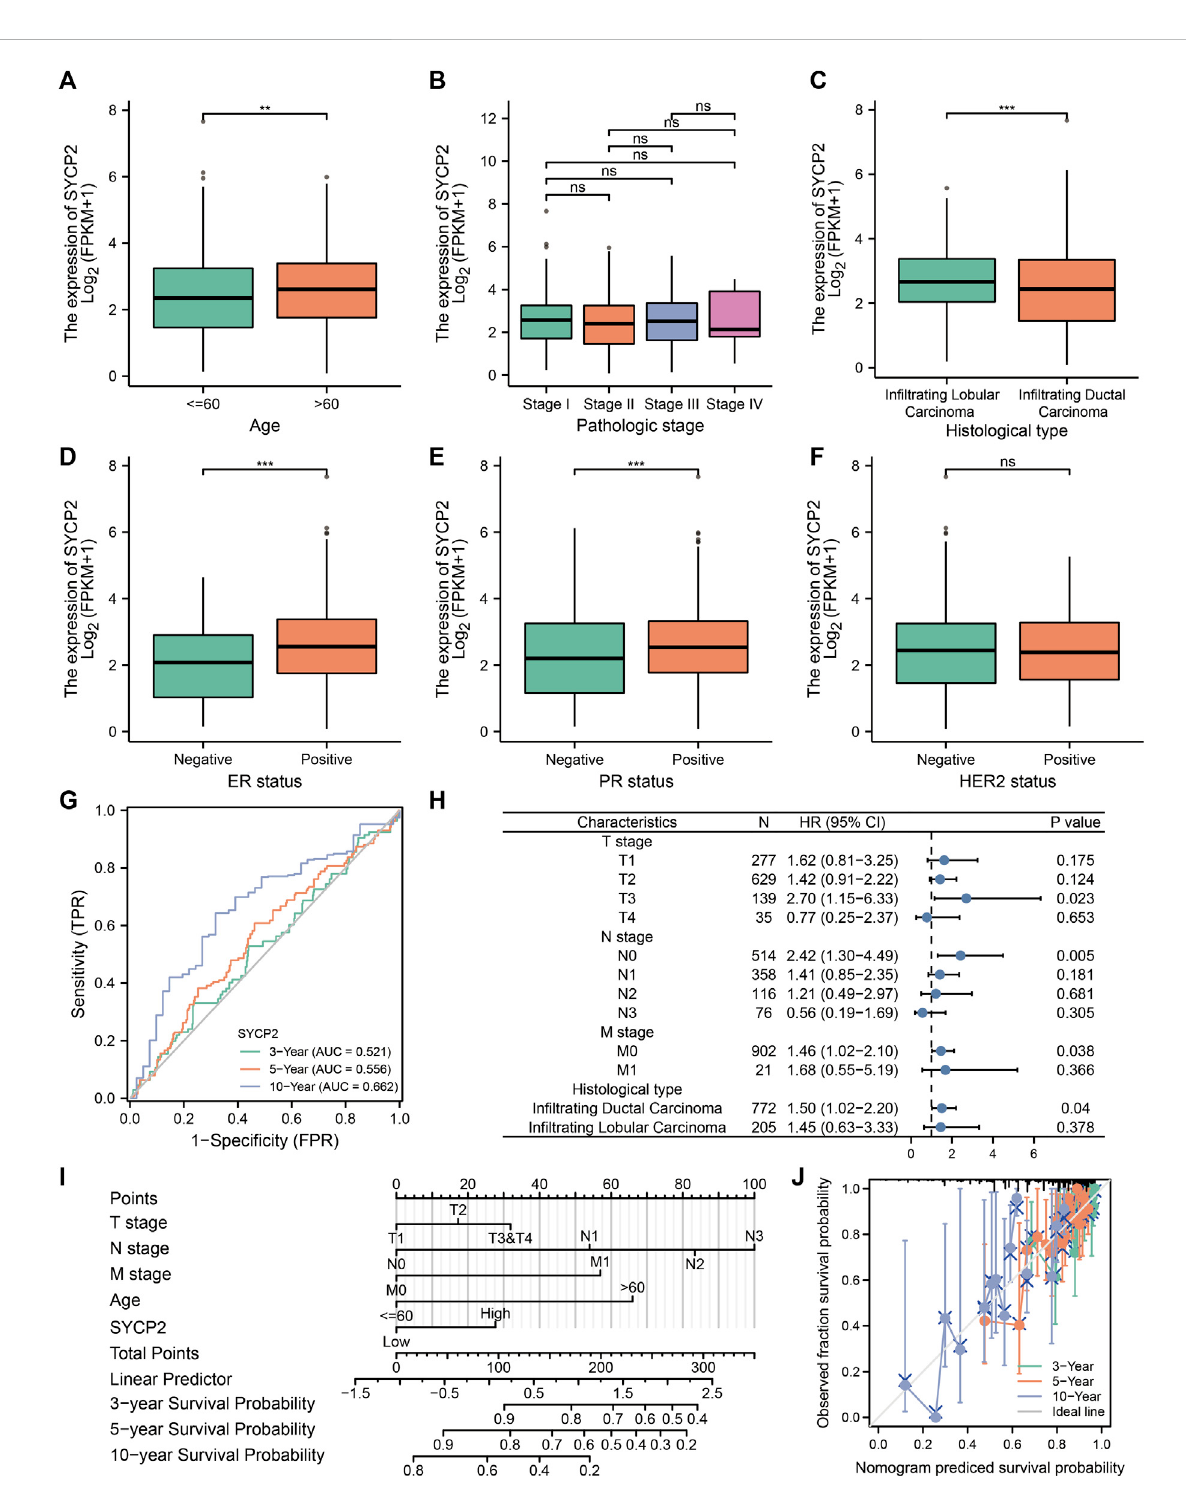
FIGURE 9 Analysis of clinical characteristics and construction of the prognostic model of patients with the expression pro fi le of SYCP2 in TCGA-BRCA. (A,C,D,E) Theexpressionpro fi leof SYCP2 showedsigni fi cantdifferencesinage,pathologicaltype,ERexpression,andPRexpression( p < 0.001). (B,F) The expression pro fi le of SYCP2 showed no signi fi cant difference in pathological stage and HER2 expression ( p > 0.05). (G) Time-dependent ROC curve. (H) Prognostic forest plot of SYCP2 in different subgroups. (I) Construction of nomogram. (J) Calibration